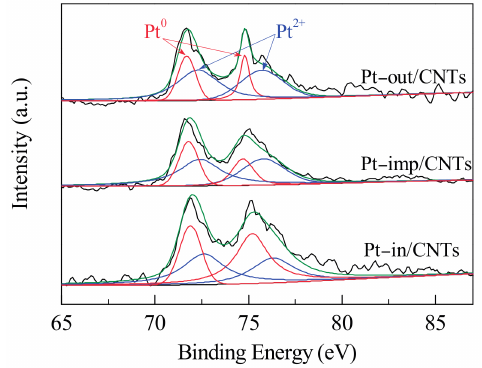
Figure 5. XPS spectra of Pt–in/CNTs, Pt–imp/CNTs, and Pt–out/CNTs.